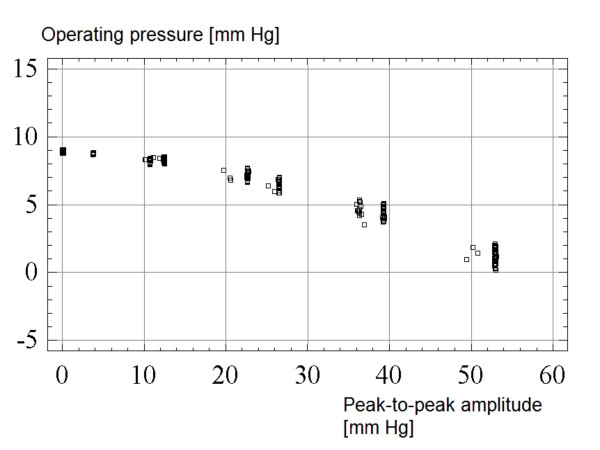
The effect of pulse amplitude: A plot of the relationship between operating pressure (y-axis) and peak-to-peak pulse amplitude (x-axis). The test was repeated 3 times in 3 valves.